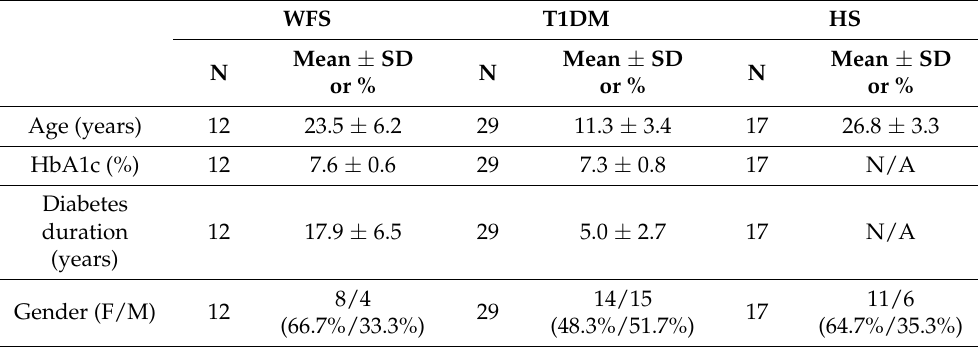
Table 2. Clinical characteristics of matched patients with WFS, T1DM, and healthy